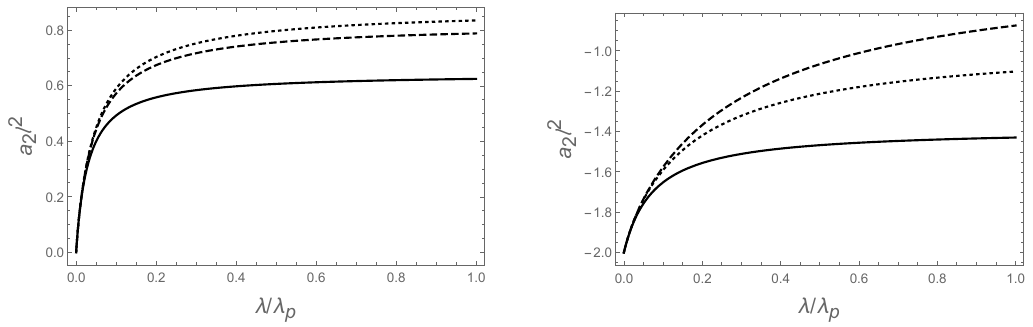
Figure 18 . Approximation of shooting parameter in terms of coupling . The shooting parameter a 2 for black branes in four (left) and (cid:12)ve (right) dimensions. In these curves we demonstrate [2 = 2], [4 = 4] and [5 = 5] order Pad(cid:19)e approximants (solid, dashed and dotted lines). Open